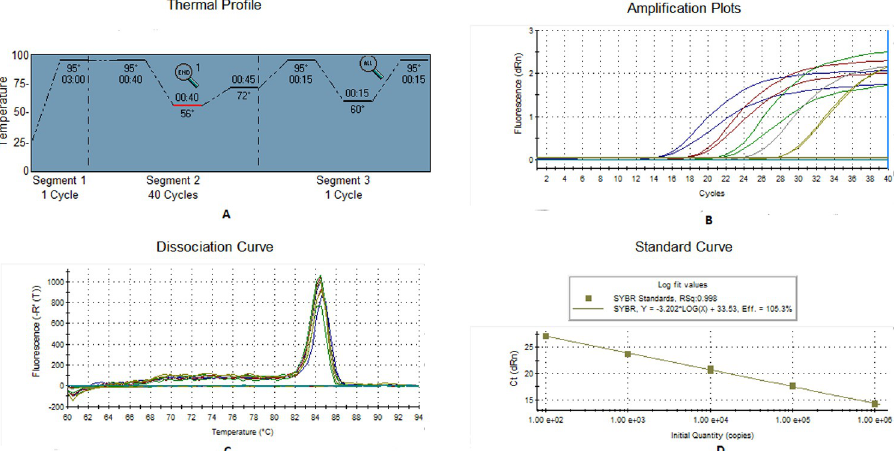
detectable targeted gene (coat protein for YVMV and OELCuV) levels. The viral copy num- bers present in both the cryptic species were represented as log converted values. The virus 10 copies in the source leaves used for acquisition of YVMV and OELCuV by B . tabaci was mea- sured to be 5.98 and 5.93 copies per microliter respectively. A total of 8 feeding periods starting from 1 min upto 24 hr were tested for both the cryptic species of B . tabaci . No viral load could be detected after 1 min of active feeding and considered as qPCR negative, whereas the